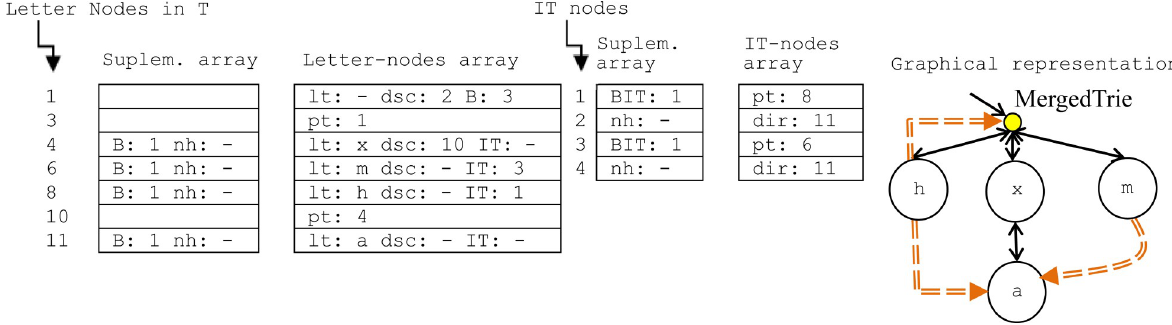
Fig 3. Sequential and graphical representations of the MergedTrie in Fig 2 after deleting the word h and running the compaction operation. Words hax and max . ( lt : letter; dsc : descendant index; IT : inter-trie index; pt : index of the parent node; nh : index of the following hash collision; dir : IT index to suffix letter-node; B : size of hash table of letter-nodes; BIT : size of hash table of IT links; root of T: